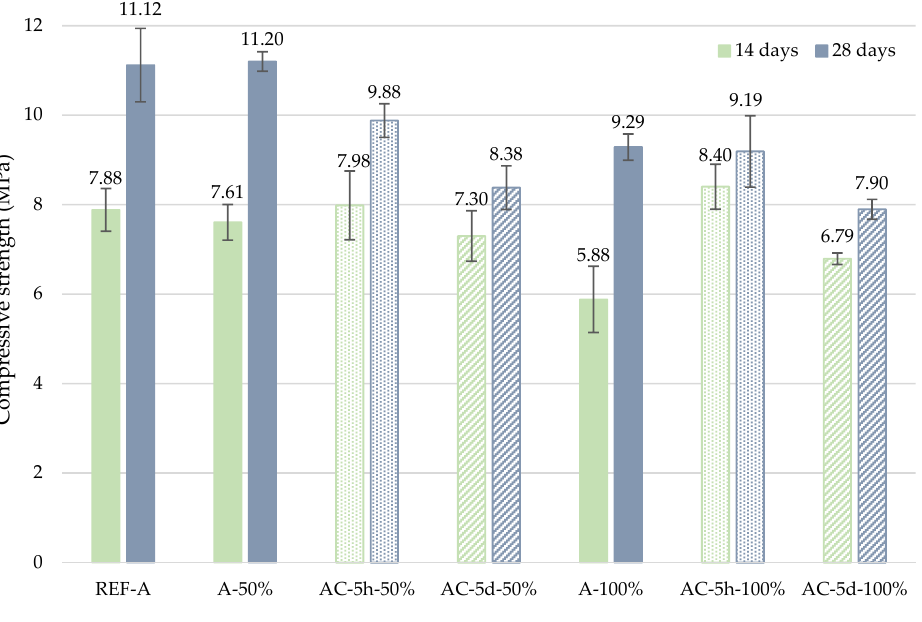
Figure 8. Compressive strength results. Table 6. Capillary coefficient of mortars incorporating CDW-A